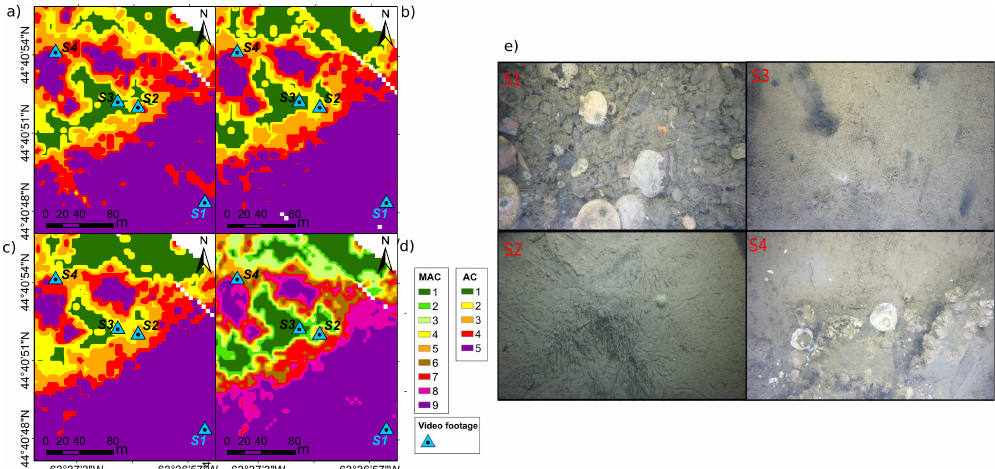
Figure 16. Subset of the acoustic classification maps generated by the Bayesian method from the Bedford Basin 2016 dataset at ( a ) 100 kHz, ( b ) 200 kHz, and ( c ) 400 kHz and ( d ) combined frequencies. The area is indicated in Figure 3 as Area 3. ( e ) Video footage of Samples S1 to S4.